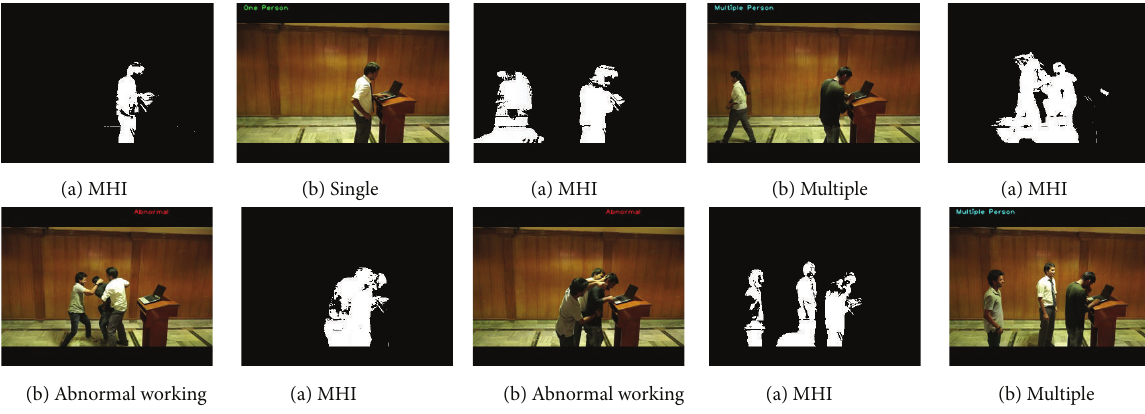
Figure 6: MHI of 10 frames (black and white (a)) and prediction by LibSVM (colored (b)) for each class (left to right).